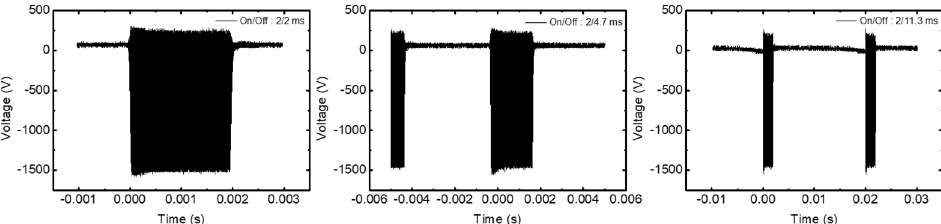
Figure 10. Input voltage of the powered electrode in pulse-modulated plasma at increasing off- time.